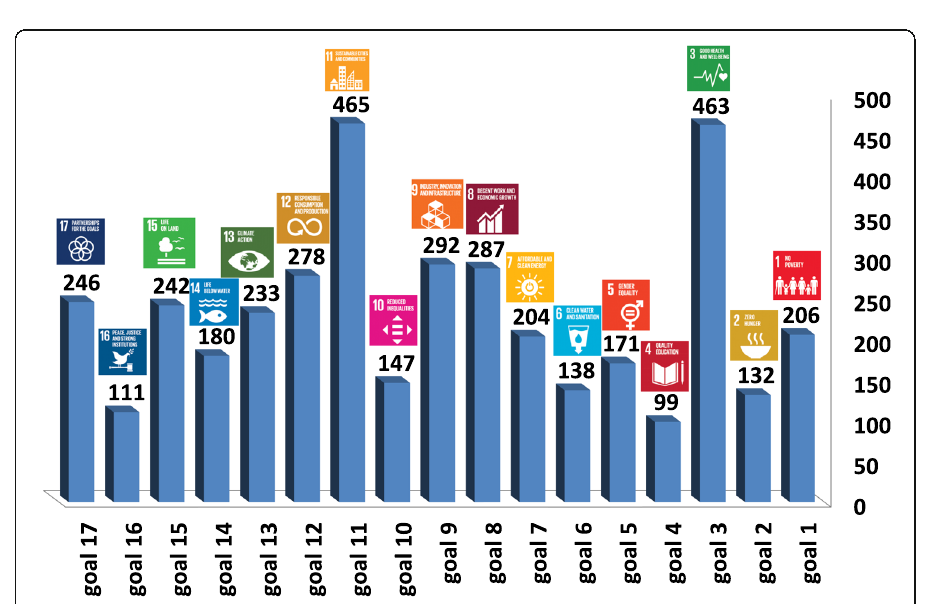
Fig. 4 SDGs and the lead of goals that are affected by SWM programs [the